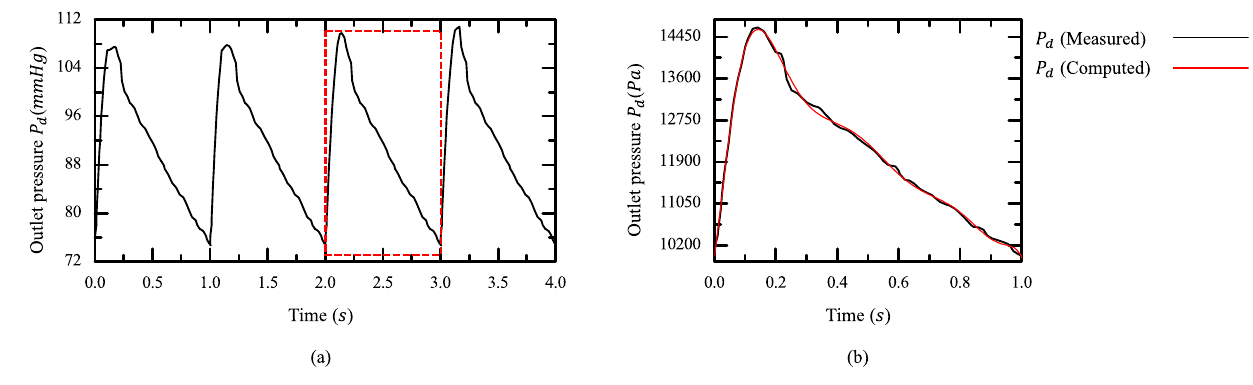
Fig. 13 The pressure profiles imposed on the artery outlets a in mmHg and b